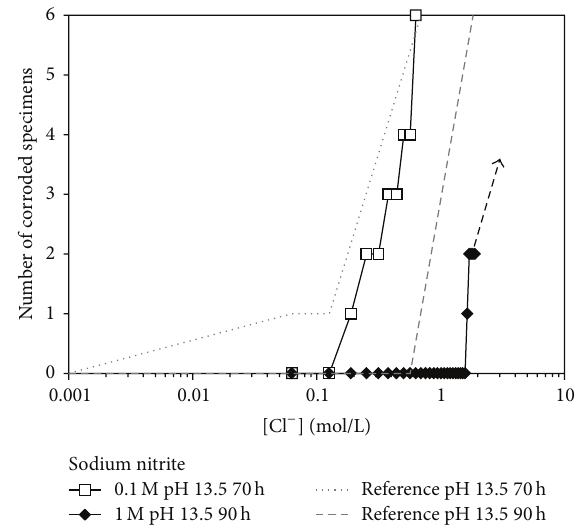
Figure 5: Number of corroded specimens as a function of chloride addition during potentiostatic test in solutions with sodium nitrite.